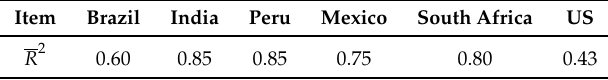
Table 4. Modified Determination Coefficients of Some Countries.